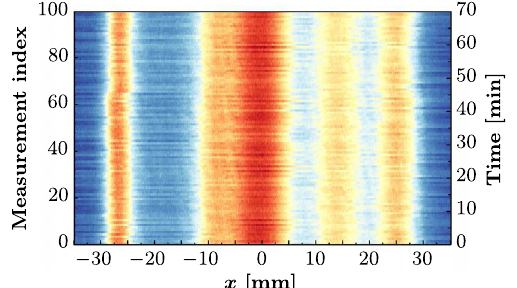
FIG. 7. Waterfall representation of multiple measured horizon- tal profiles after an intervention aimed at damping the current ripple of the PFWs at 5 kHz. Significantly improved stability with respect to the measurements shown in Fig. 3 is clearly visible.